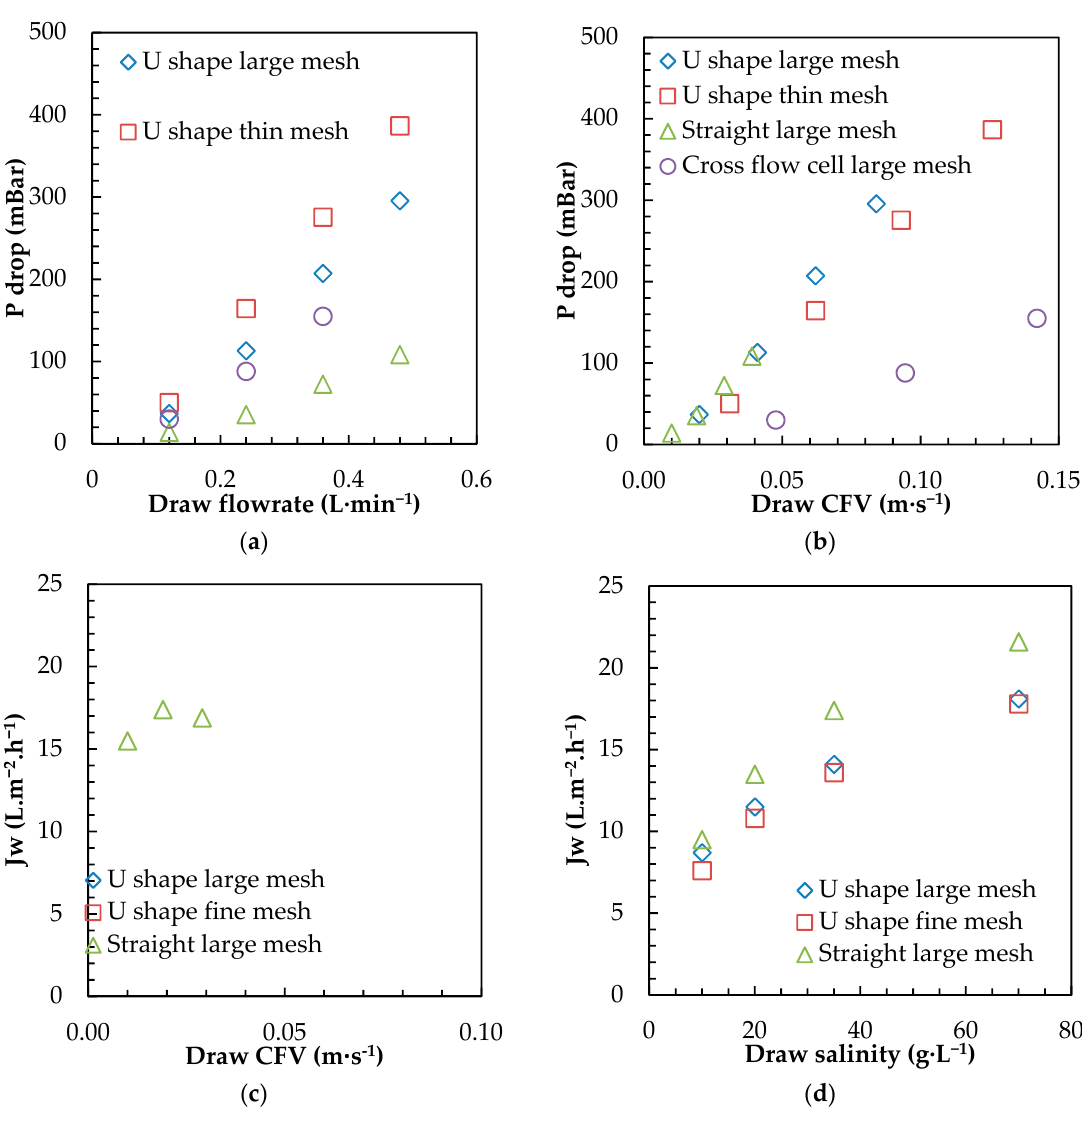
Figure 6. Impact of ( a ) draw pumping flow rate and ( b ) CFV on pressure drop in tested P&F modules (DI water as feed and draw solutions, draw pumping operated in suction). Water permeation flux as a function of ( c ) draw CFV and ( d ) draw salinity for the 3 tested P&F modules (DI water as feed 35 g·L − 1 SW as draw, draw pumping operated in suction, feed side under mechanical stirring).